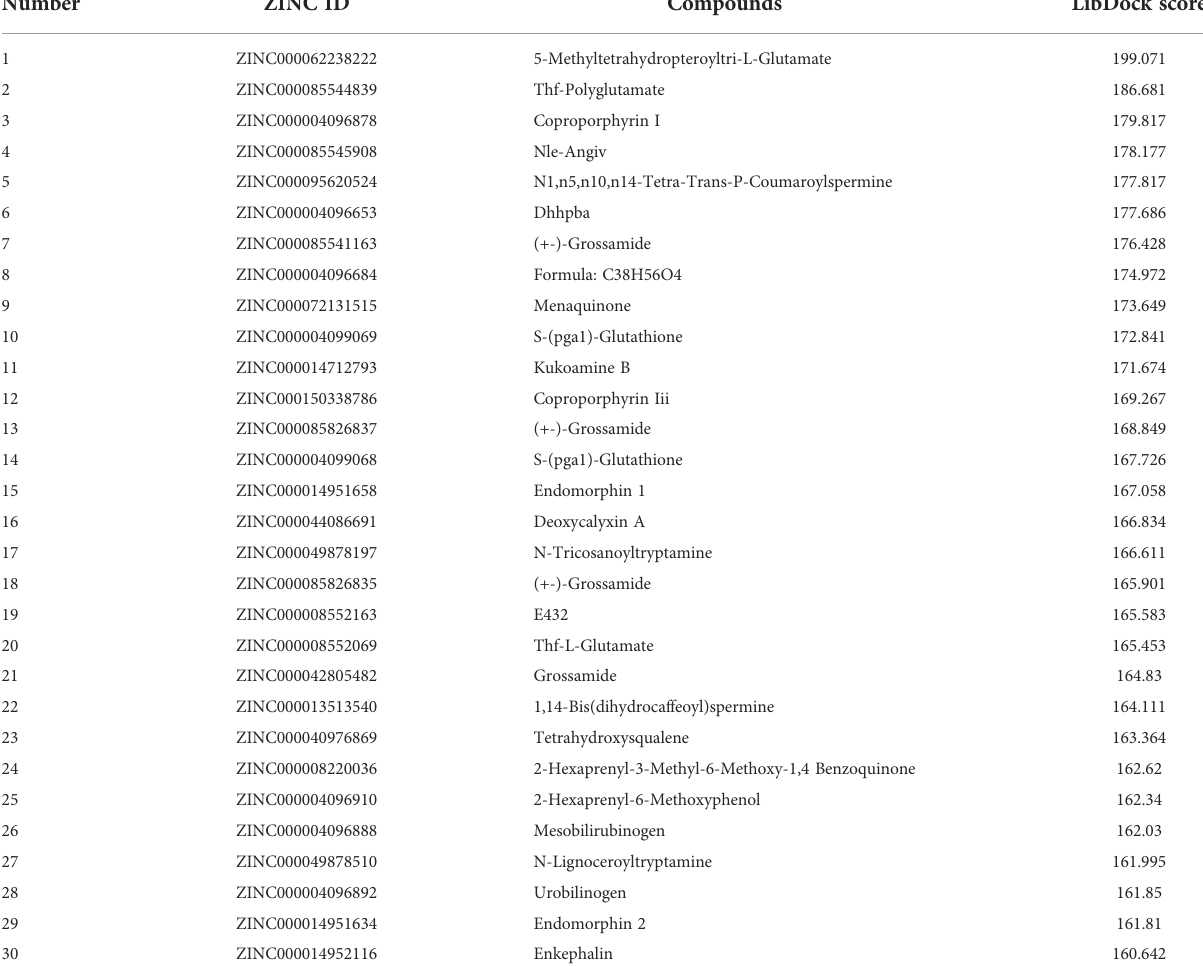
TABLE 1 Top 30 ranked materials with the highest docking